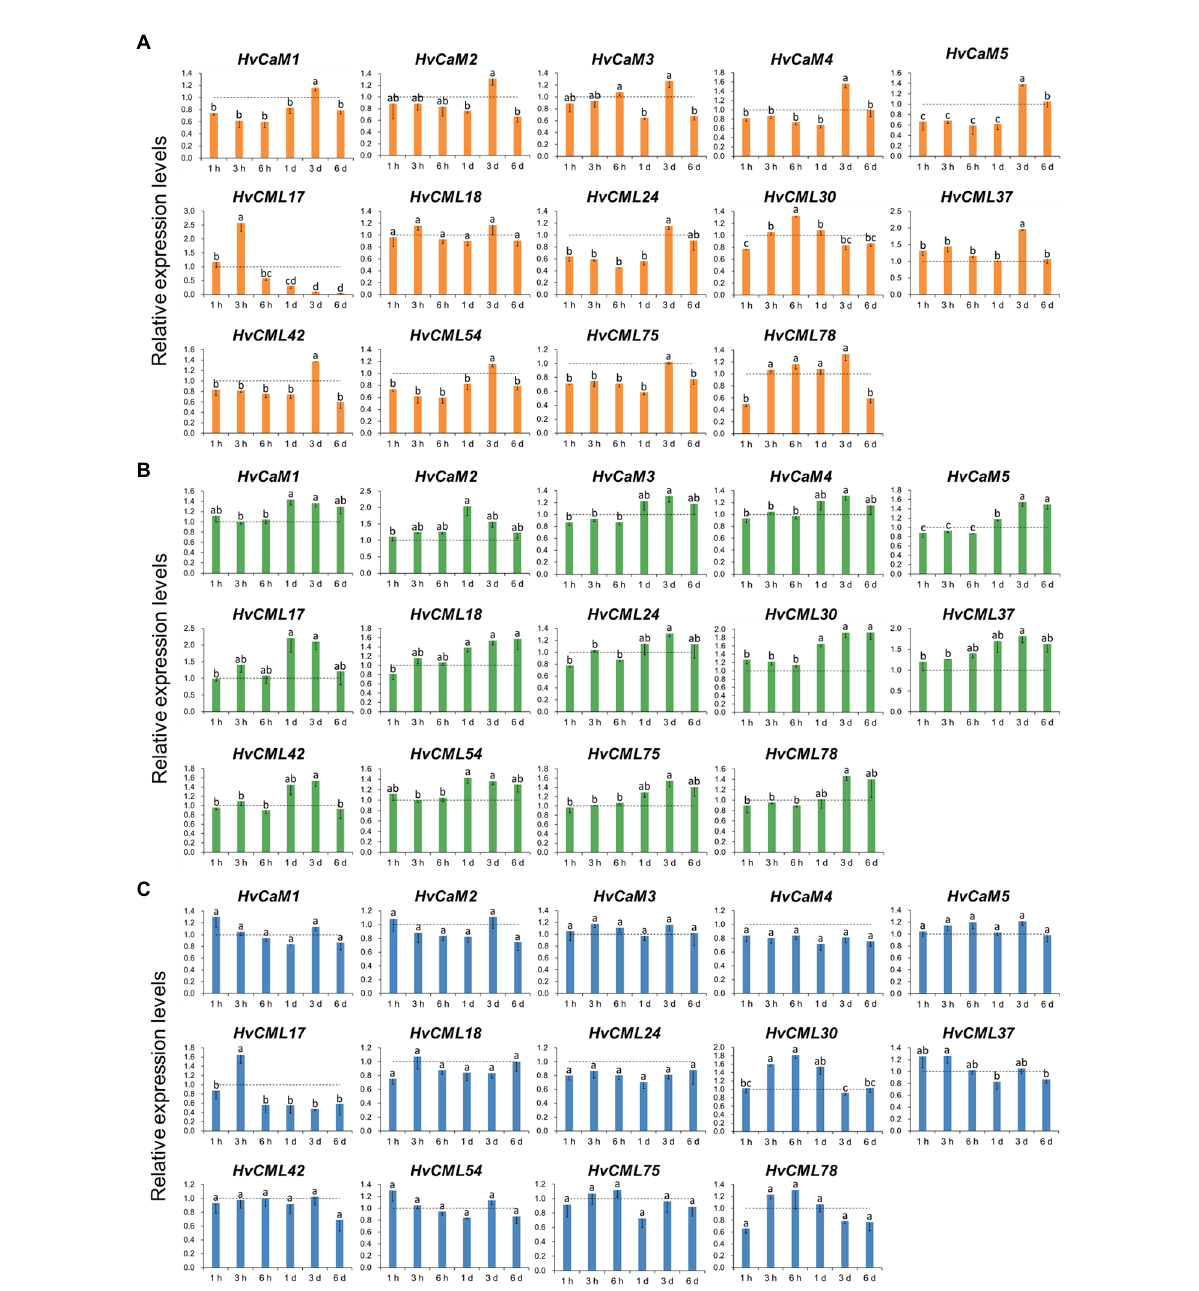
FIGURE 8 Expression levels of 14 HvCaMs/CMLs in response to salt stress (A) , potassium deficiency (B) and osmotic stress (C) at seedling stage. Dotted lines indicated the expression levels of HvCaMs/CMLs in control seedlings. Lowercase letters indicated the significant difference at p <